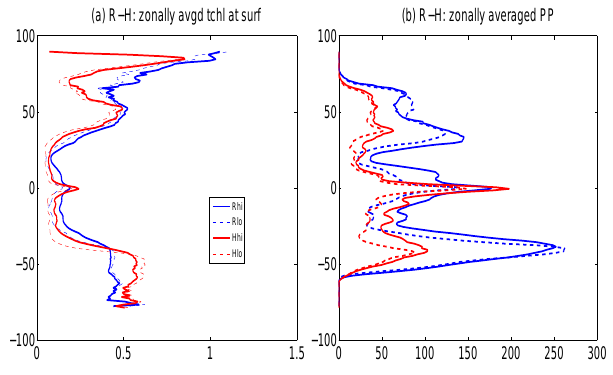
Fig. 8. Zonally averaged (a) total chlorophyll at the surface (mgchlm − 3 ) and (b) primary productivity vertically integrated (mgCm − 2 d − 1 ). Continuous lines are for high remineralization rate and dashed for low remineralization rate. Blue lines are for GISSER and red lines for GISSEH. Fig. 9. (a) Zonally integrated carbon export at 75m in PgCyr − 1 . Color scheme is same as in previous figures. (b) Zonal mean vertical fluxes across 75m depth for the Russell model: carbon export (R-lo, continuous line), vertical advection flux (multiplied by 10, dashed line), vertical flux associated with the Gent–McWilliams scheme (multiplied by 10, solid line with crosses – not well visible on this diagram as it coincides with the axis) and vertical flux associated with vertical mixing (multiplied by 10, solid-circle line). All fluxes are positive down.